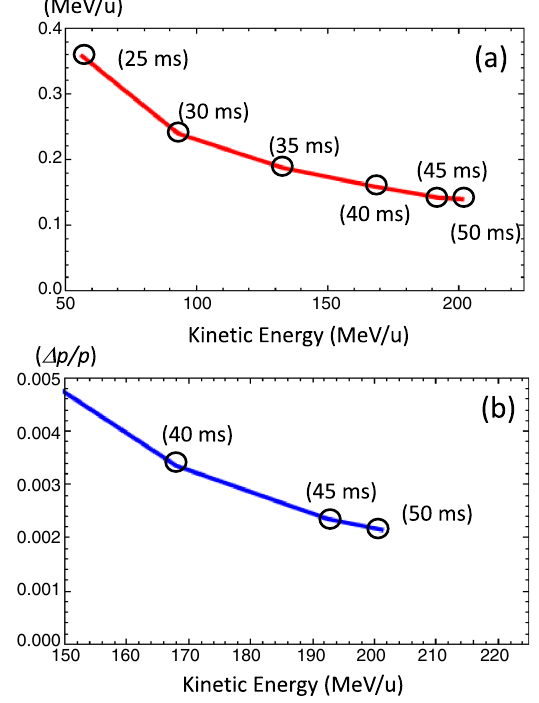
FIG. 22. (a) Energy loss vs. kinetic energy of a projectile carbon ion and (b) Momentum change per pass vs. kinetic energy of a projectile carbon